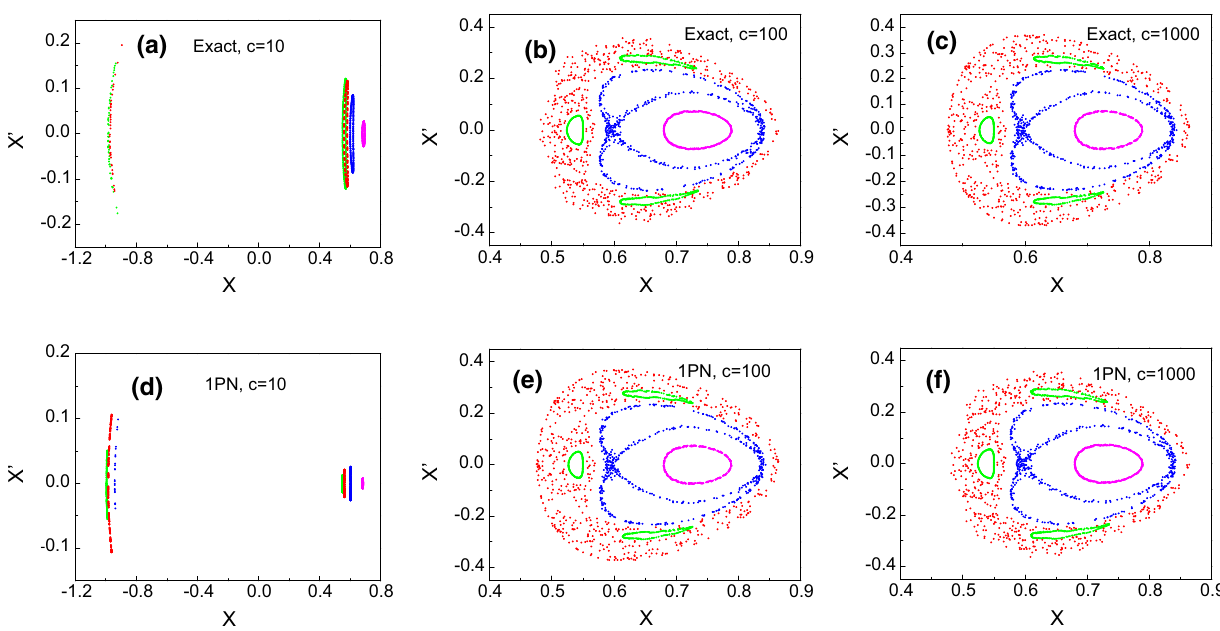
Fig. 7 Poincaré surface sections of Orbit 1 (green), Orbit 2 (red), Orbit 3 (blue), and Orbit 4 (magenta) respectively in the exact system (12) and the 1PN truncated system (16)–(17) with different c